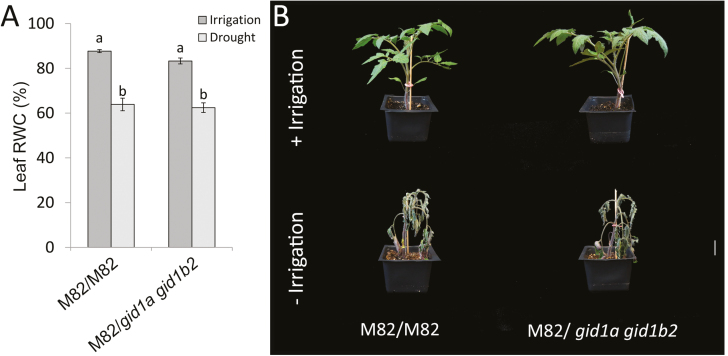
Grafting of M82 scions on M82 or gid1a gid1b2 rootstocks. Grafted plants were grown for 2 weeks under normal irrigation (+irrigation) and then irrigation was stopped for dehydration (−irrigation). (A) After 4 d, when plants started wilting, leaf RWC was measured. Values are mean of six plants ±SE. Lowercase letters represent significant differences between the lines (Student’s t-test, P<0.05). (B) After 7 d of the water-deficit treatment, representative plants were photographed.